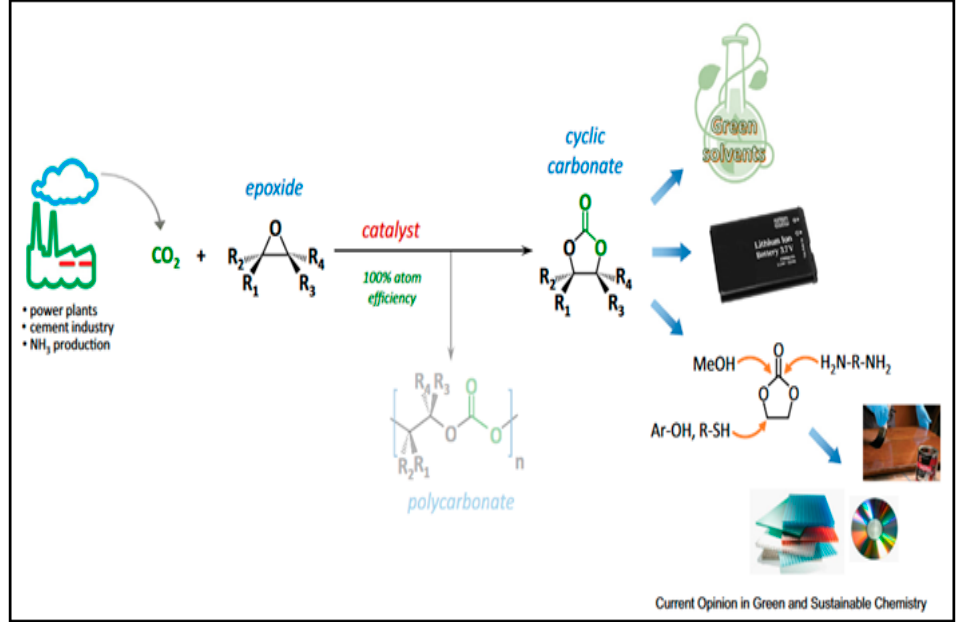
Figure 6. Preparation of cyclic carbonates by CO 2 fixation and some utilizations of the cylic cabonate [54].